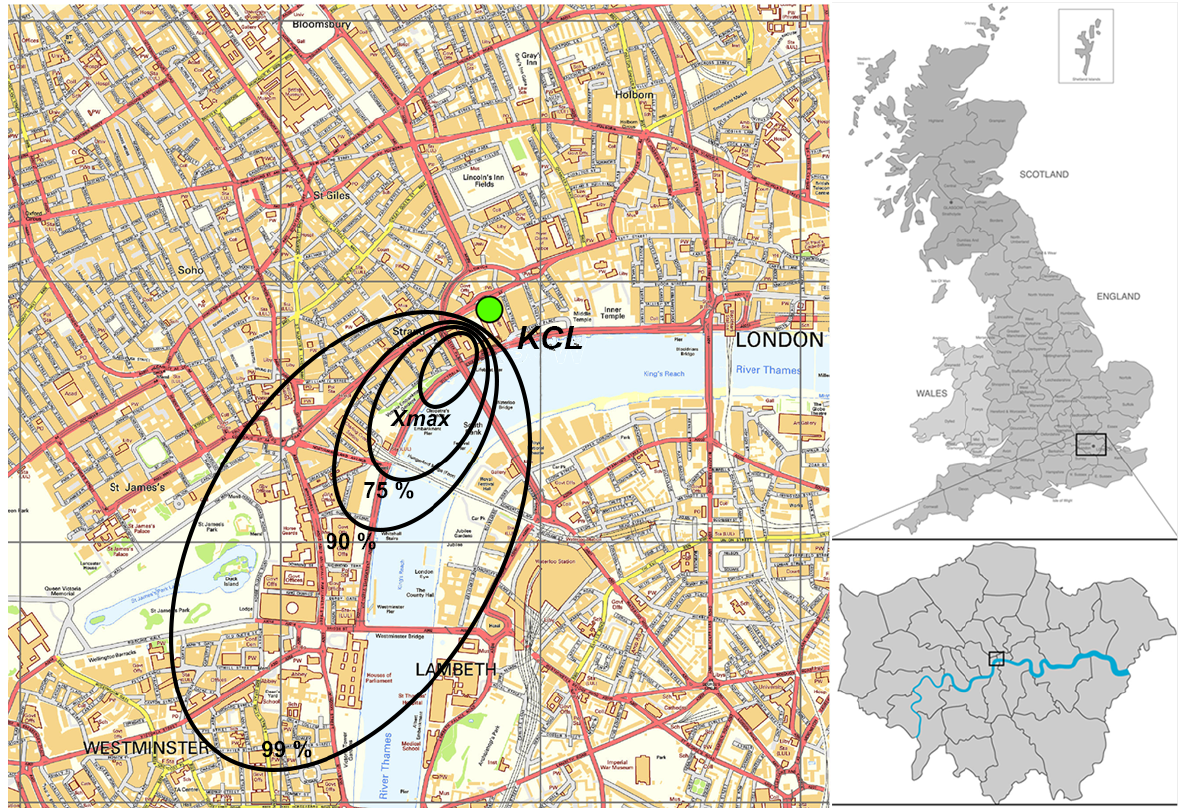
Figure 1. Map of central London overlaid with the Ordnance Survey grid including the measurement site (KCL) at King’s College (green point) with references to the geography of Greater London and Great Britain. Outlines of the areas that contribute the maximum ( X max ) as well as 75, 90 and 99% to the flux footprint using overall median meteorological values are shown as black contour lines with their respective labels laid out according to the median wind